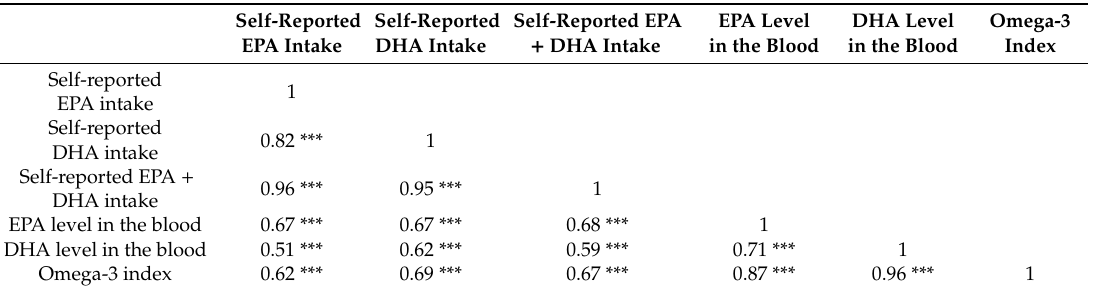
Table 3. Person correlation matrix between self-reported intake of EPA and DHA, and blood levels of EPA, DHA and omega-3